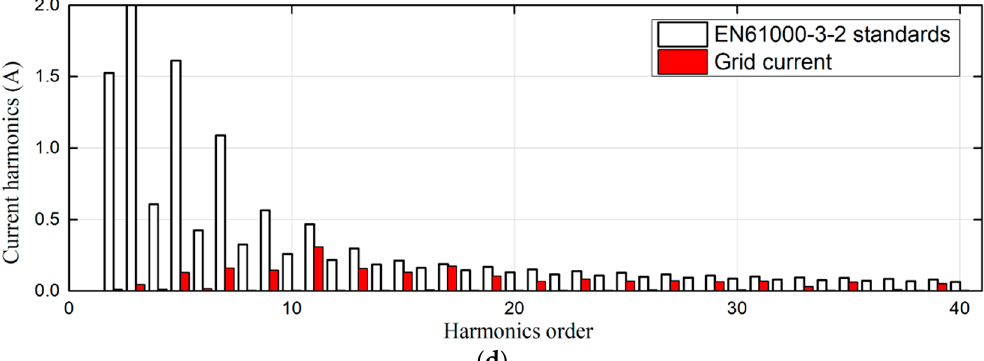
Figure 20. Experimental result of the FSMO estimate method with a PI controller: ( a ) Motor Speed; ( b ) Position and estimated error; ( c ) DC-link voltage and grid current; ( d ) FFT analysis of grid current.